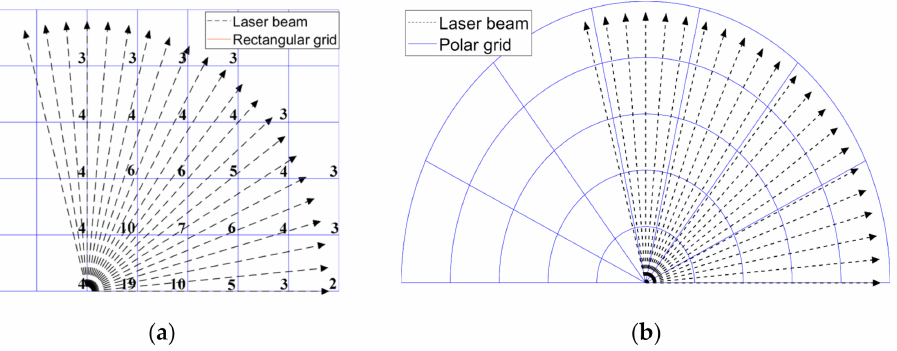
Figure 3. Comparison between a rectangular grid and a polar grid. The number in ( a ) is the number of laser beams passing through each cell. In ( b ), different cells in the polar grid correspond to similar number of laser beams. The comparison shows that the polar grid achieves a more even data